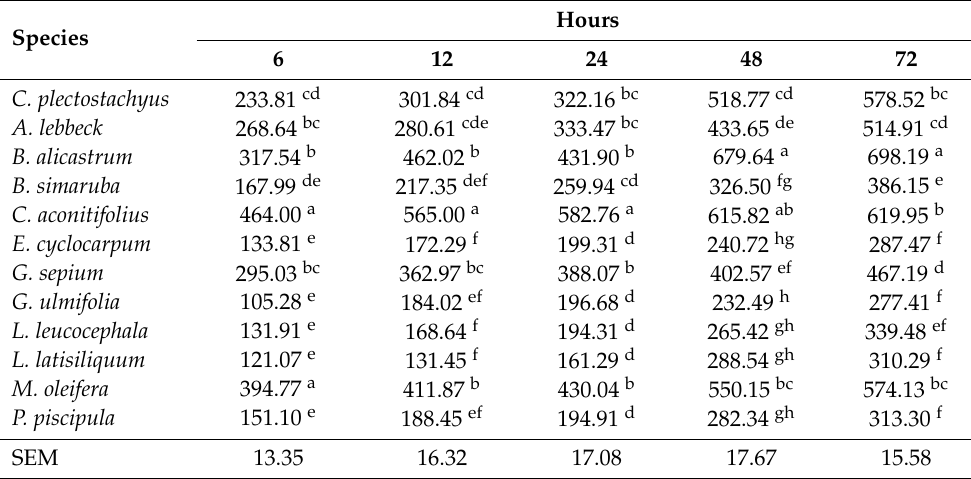
Table 2. Dry matter degradability (DMD) of the foliage of tropical trees and shrubs at different in vitro ruminal fermentation times (mg/g DM).